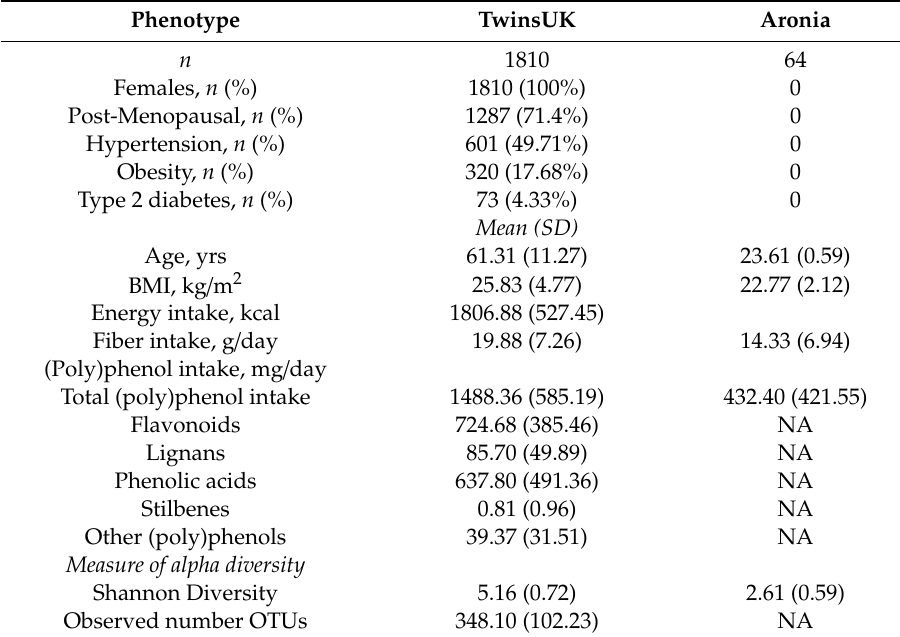
Table 1. Demographic characteristics of the study